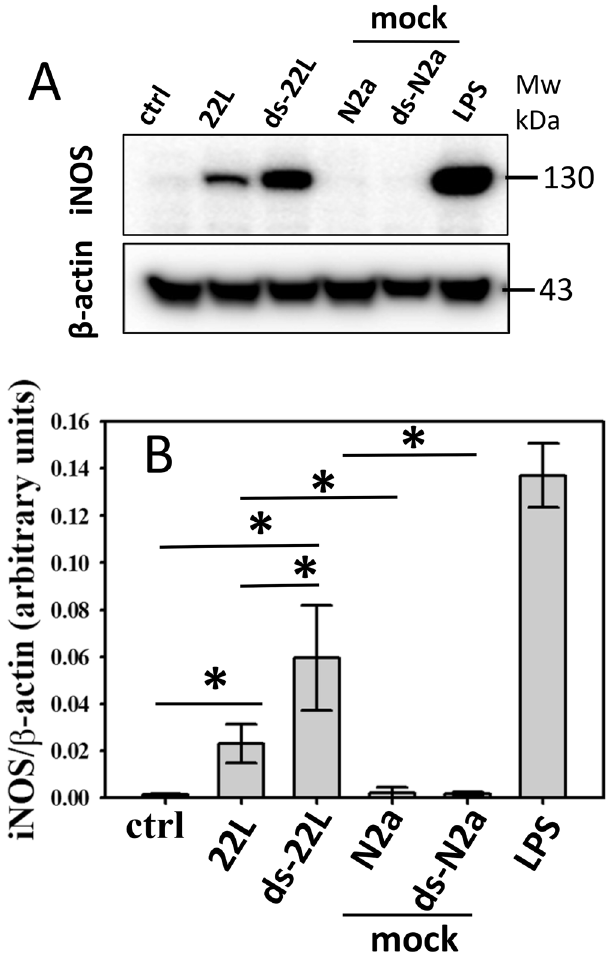
Figure 6. Analysis of iNOS expressions in BV2 cells treated with cell-derived PrP Sc . ( A ) Western blot analysis of expression levels of iNOS in BV2 cells exposed to purified, ScN2a-derived 22L or ds-22L PrP Sc for 18 hours. As negative controls, cells were treated with mock-purified N2a or ds-N2a, or cultured in the absence of treatment (ctrl). As a positive control, cells were treated with LPS (100 ng/ml). The final concentrations of ScN2a derived 22L or ds-22L PrP Sc in the cell culture media were equivalent to the amounts of PrP Sc in 0.15% 22L scrapie brain homogenate. Western blots probed with anti- β actin antibody served as protein loading control. Three independent experiments were performed. Full-length Western blots are shown in Supplementary Fig. S4. ( B ) Densitometry analysis of iNOS expression in BV2 cells exposed to purified, ScN2a-derived 22L or ds-22L PrP Sc . The data were normalized relative to the intensity of the β actin. The data are presented as the mean ± SD (n = 3 independent experiments). Statistical significance (P) were calculated by Student’s t-test and indicated as * for P <